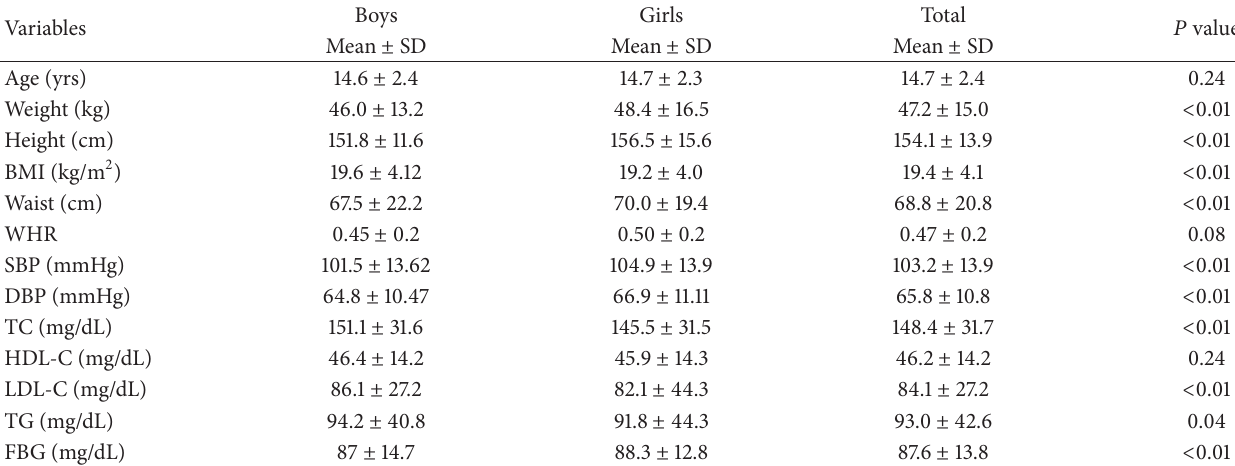
Table 1: Descriptive characteristics of the study participants according to gender: CASPIAN III Study.